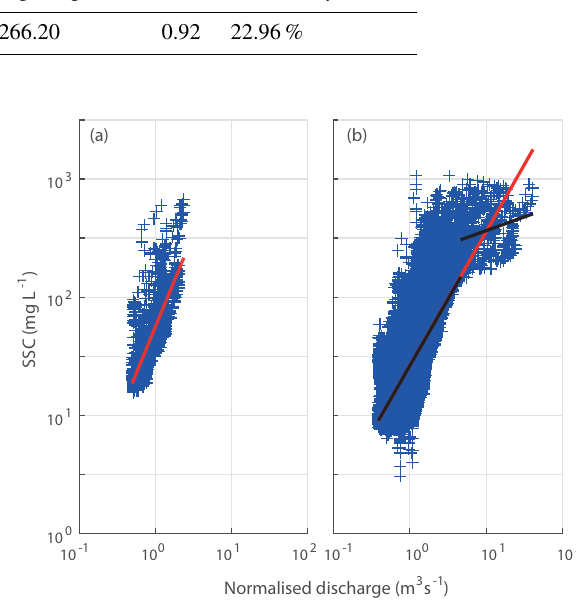
Figure 5. Relationship between normalized discharge and sus- pended sediment concentrations (a) before and (b) following the diversion of Glaisdale Beck. The red line represents all the available data for the time period. The broken black line represents the thresh- old models for normalized discharge within the range of greater than and less than 4.6m 3 s − 1